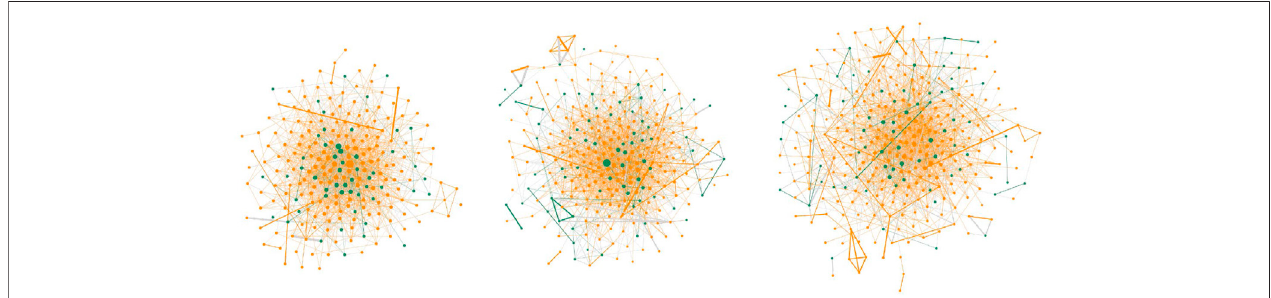
FIGURE 6 | Collaboration network for the Saturn Award. Three collaboration networks from the years 1990 – 1999, 2000 – 2009, and 2010 – 2019 are shown. The number of nominated actors and actresses increases by year, while the chances of winning the prize are getting more dif fi cult in recent years (22%, 23%, and 18%). Green dots represent prize-winners, and orange dots represent nominees without prizewinning.